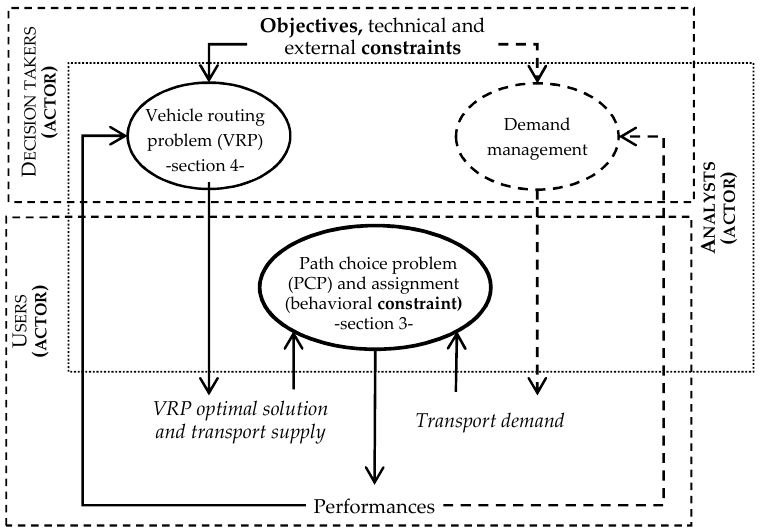
Figure 2. Functional architecture in a decision support system.